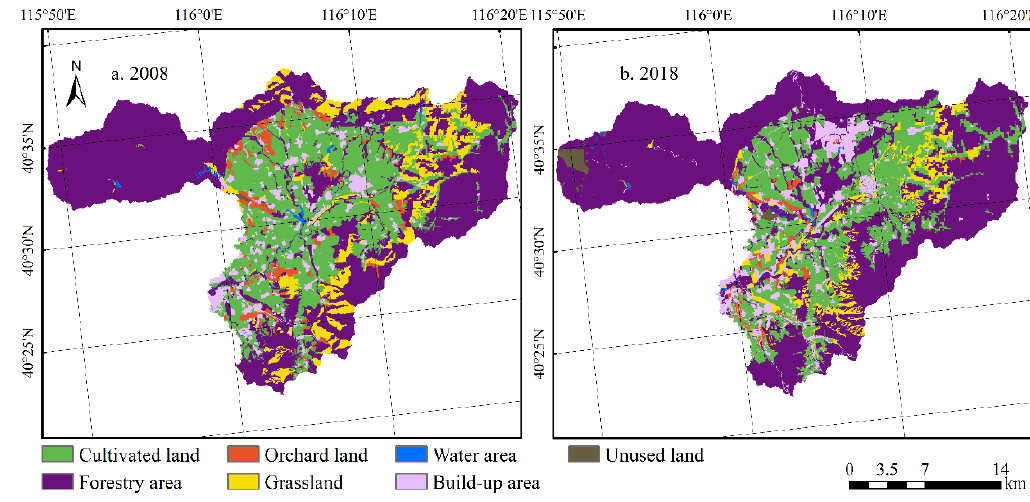
Figure 12. Spatial distribution of land use in Guishui River Basin in 2008 and 2018.